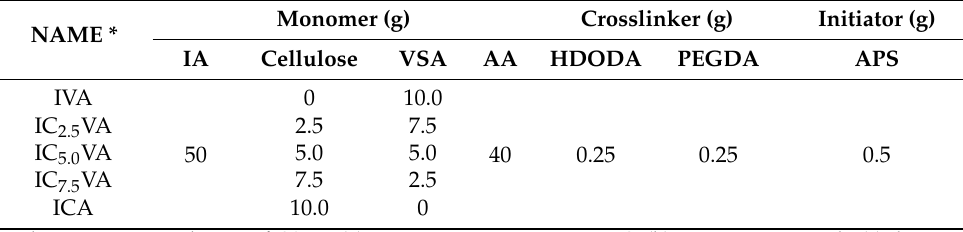
Table 1. Synthetic composition of CSAP (core-superabsorbent polymer (SAP)). NAME